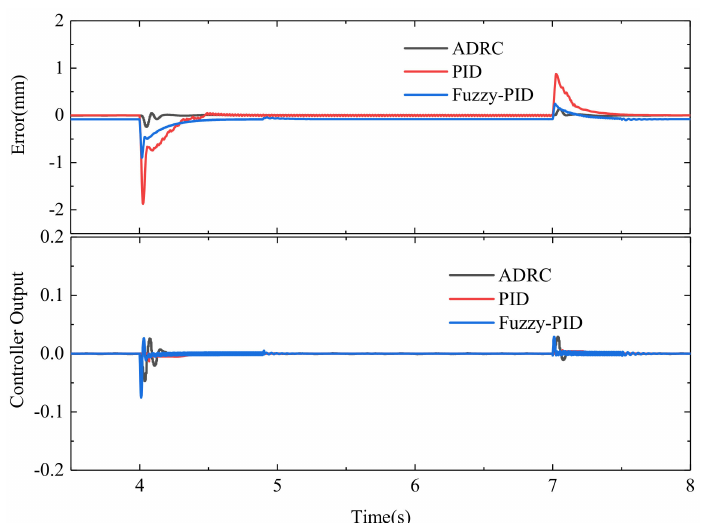
Figure 9. Response to step load.